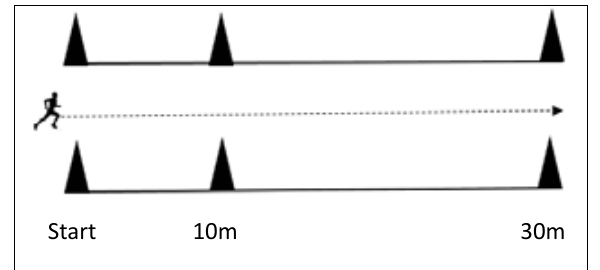
Figure 2. Sprint Test Track